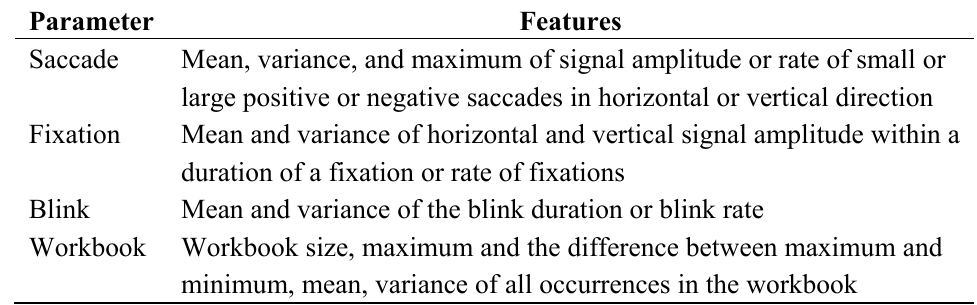
Table 13. Selected optimal features for the classification of the ADL communication and leisure from EOG